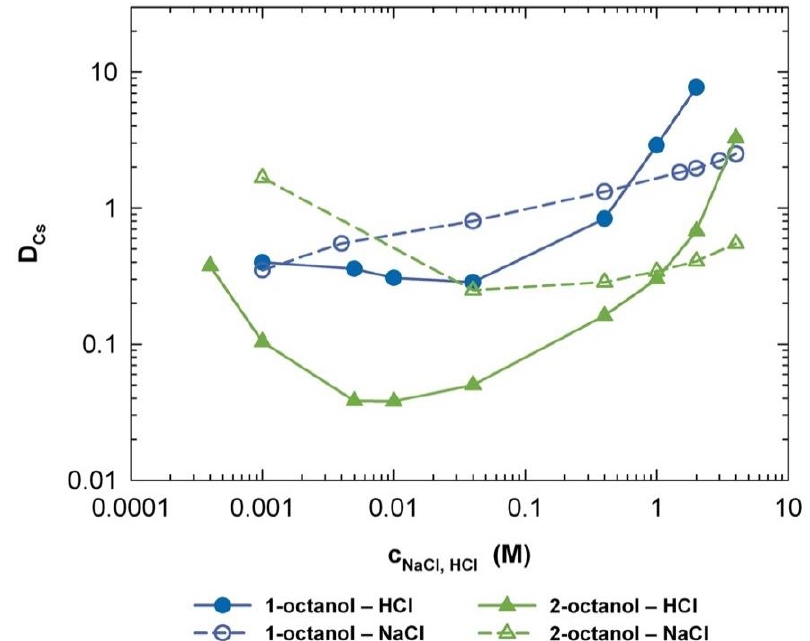
Figure 6. D Cs versus initial NaCl or HCl concentration. Organic phase, 0.01 M MAXCalix in 1-octanol or 2-octanol. Aqueous phase, (NaCl + 0.001 M HCl) or HCl + 137 Cs (10 kBq/mL).